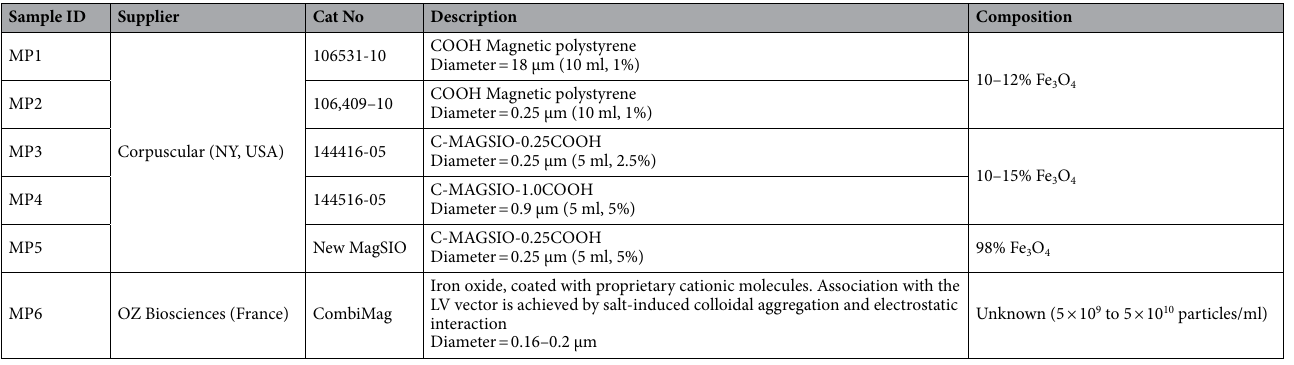
Table 1. Properties of the six particles tested at SPring-8 BL20XU.